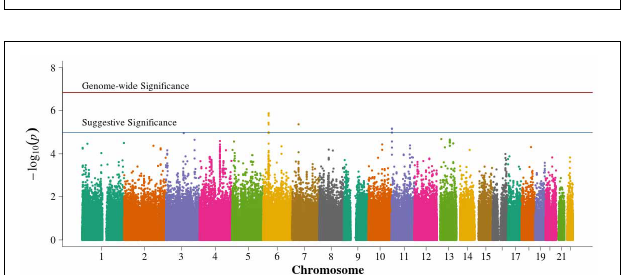
FIGURE 3 | Manhattan plot for population-based study with case and control singletons only. Summary of genome-wide association scan results in the GoKinD cases and controls, singletons only. The − log 10 P -values were calculated for SNP association with diabetic nephropathy among subjects with type 1 diabetes using the Cochran-Armitage test for trend for an additive genetic model adjusted for sex and stratified by center ascertainment using Cochran-Mantel-Haenszel method. The red horizontal line corresponds to genome-wide significance ( P -value = 0 . 05 / 384 , 094 = 1 . 3 × 10 − 7 ). The blue horizontal line corresponds to suggestive significance ( P -value = 1 × 10 − 5 ).